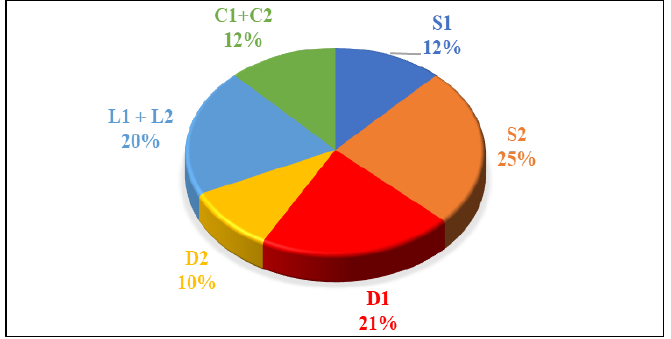
Figure 10. The breakup of losses of the proposed converter at 25 W output.